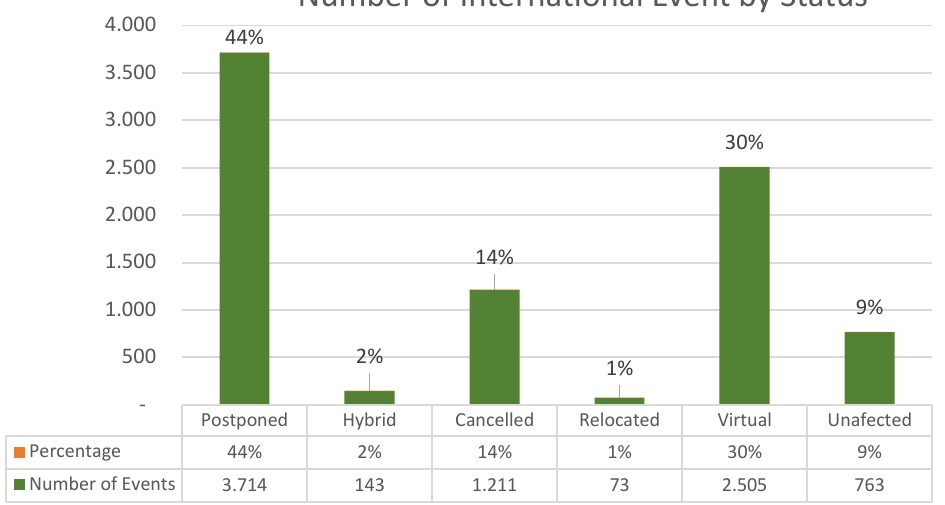
Figure.2 Number of International MICE Event by Status Along The Pandemic Covid-19